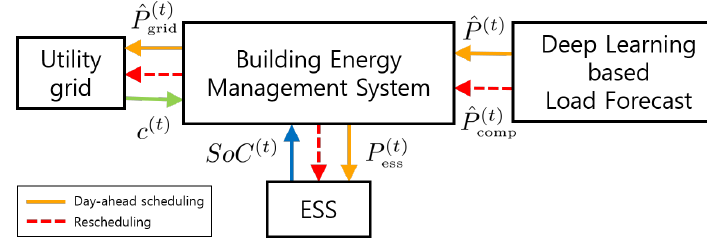
Figure 7. Structure of the proposed Building Energy Management System